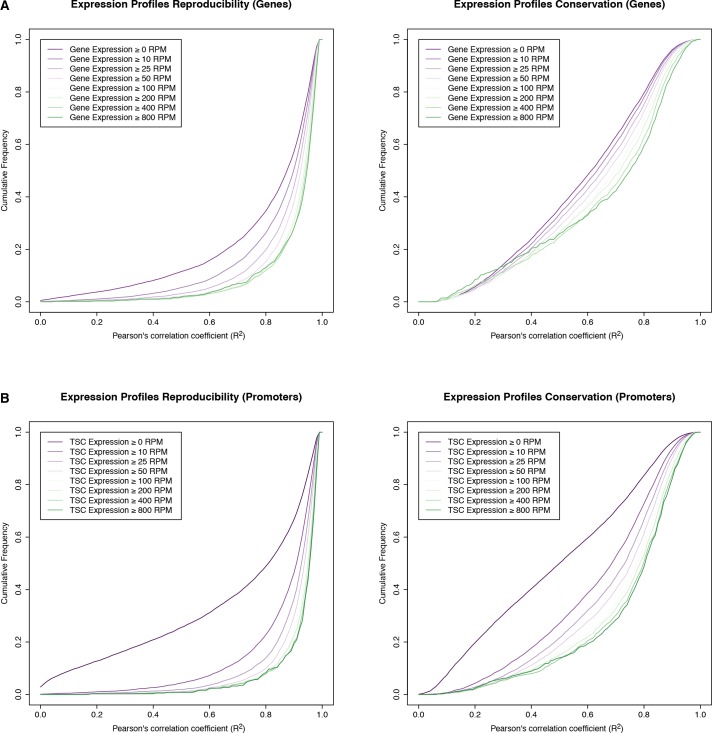
Reproducibility of expression time series.Reproducibility of expression profile measurements for genes (A) and individual TSCs (B). The graphs represent cumulative distributions of expression profile correlations across D. melanogaster biological replicates (left), and across all species (right). We only considered genes whose maximum expression level throughout the D. melanogaster time series (replicate 1) exceeded a given threshold (see legends; RPM: reads per million). Note that the variation across species vastly exceeds the variation across replicates, at all expression thresholds considered.